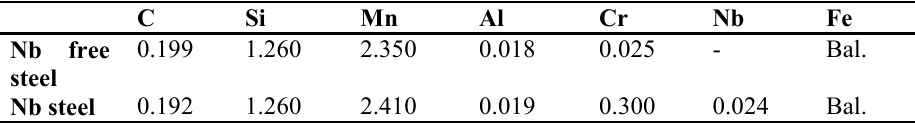
Table 1: Chemical composition of steel used (wt%) C Si Mn